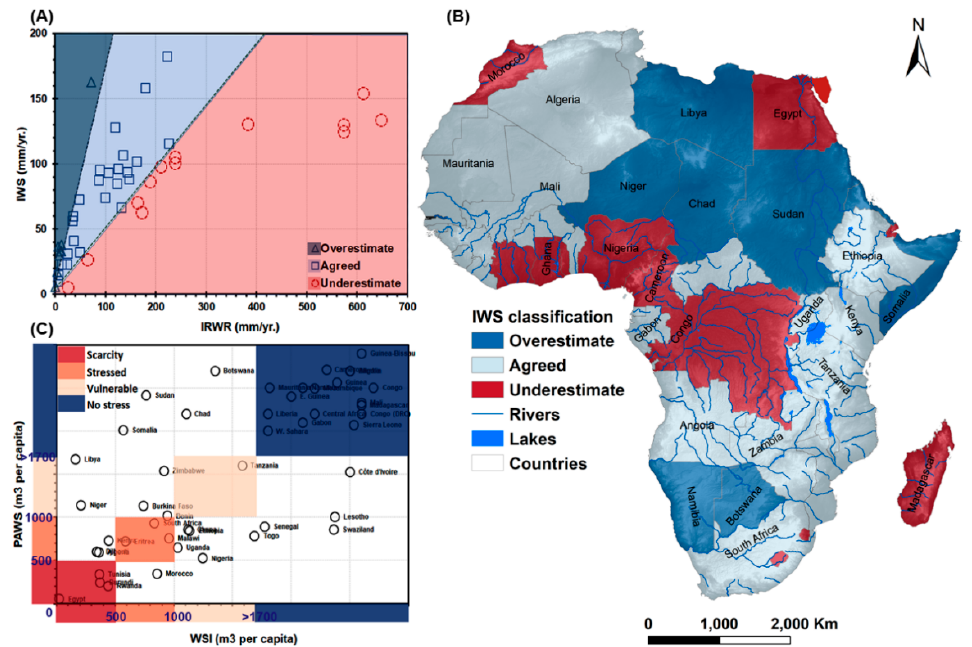
Figure 4. Estimated countries’ Internal Water Storage (IWS) versus the AQUASTAT- Internal Renewable Water Resources (IRWR) ( A ), this plot indicates the three main classes of the estimation (agreed, overestimate, and underestimate), the spatial distribution of these classes is shown in the map ( B ). Based on the calculated IWS, the Potential Available Water Storage (PAWS) will follow the same pattern when compared to Water Scarcity Index (WSI) indicator ( C ).